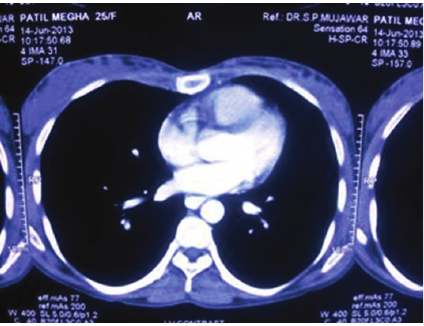
Figure 4: CT scan transverse section.